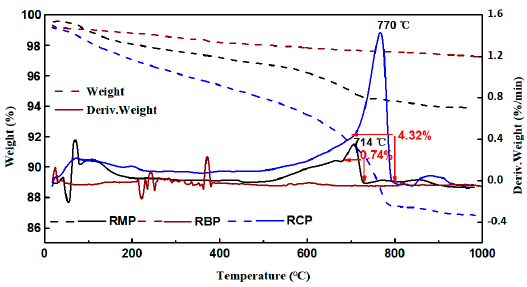
Figure 9. The TG-DTA test results of various RPs.